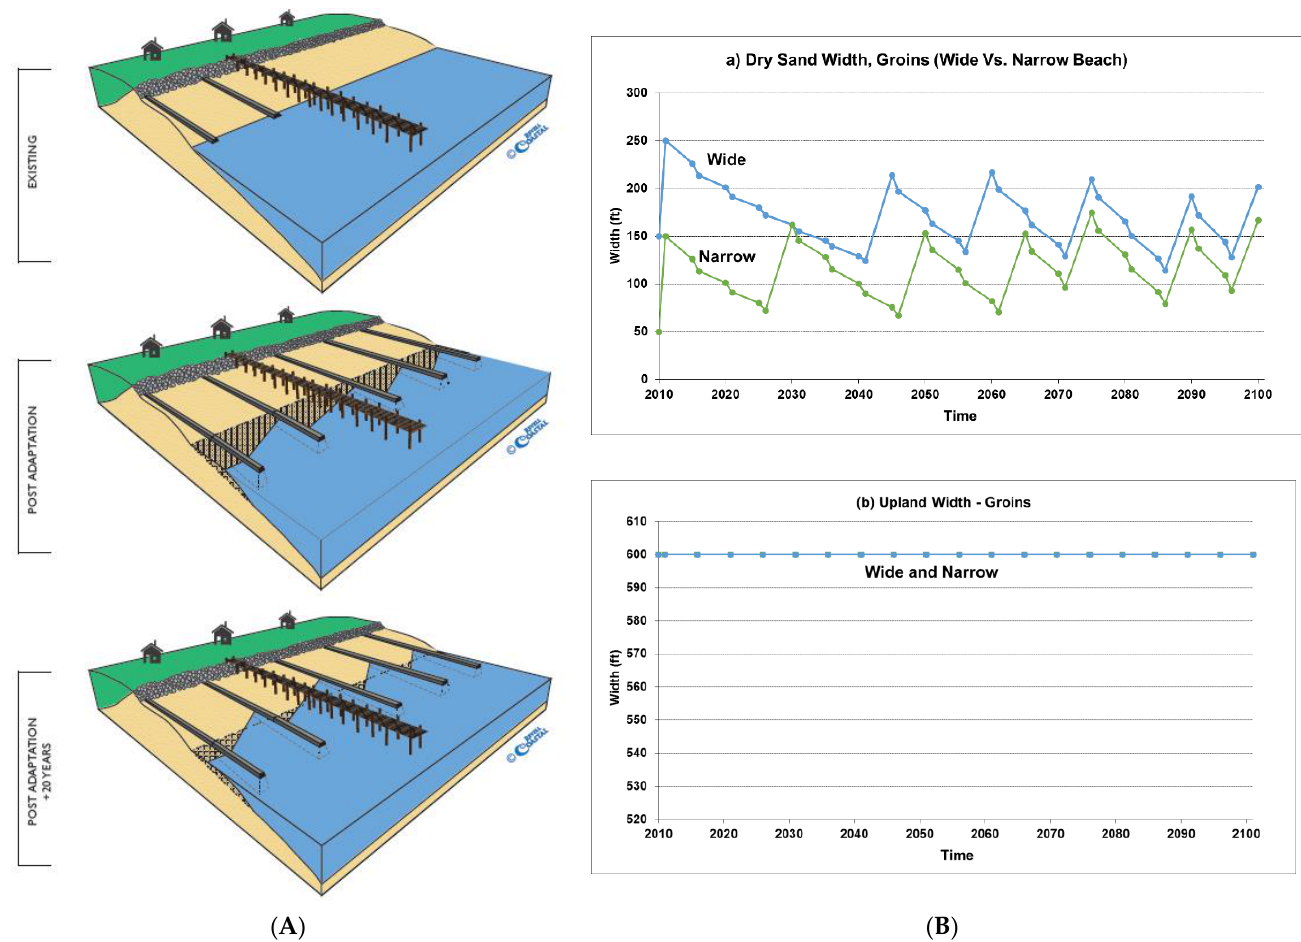
Figure 11. ( A ) Sand retention with groins adaptation strategy over time. ( B ) Dry sand beach width over time with armoring (wide vs. narrow beach) (Ba top plot); upland width over time with armoring (wide vs. narrow beach) (Bb bottom plot).